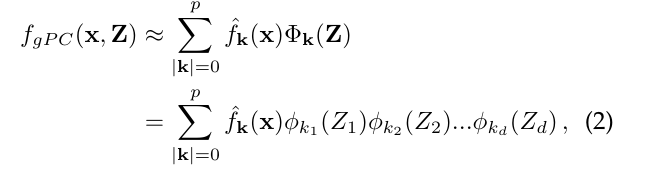
For problems with several random input variables, Z : Ω → R d denotes the d -dimensional vector of ran- dom variables and (1) is replaced by a tensor